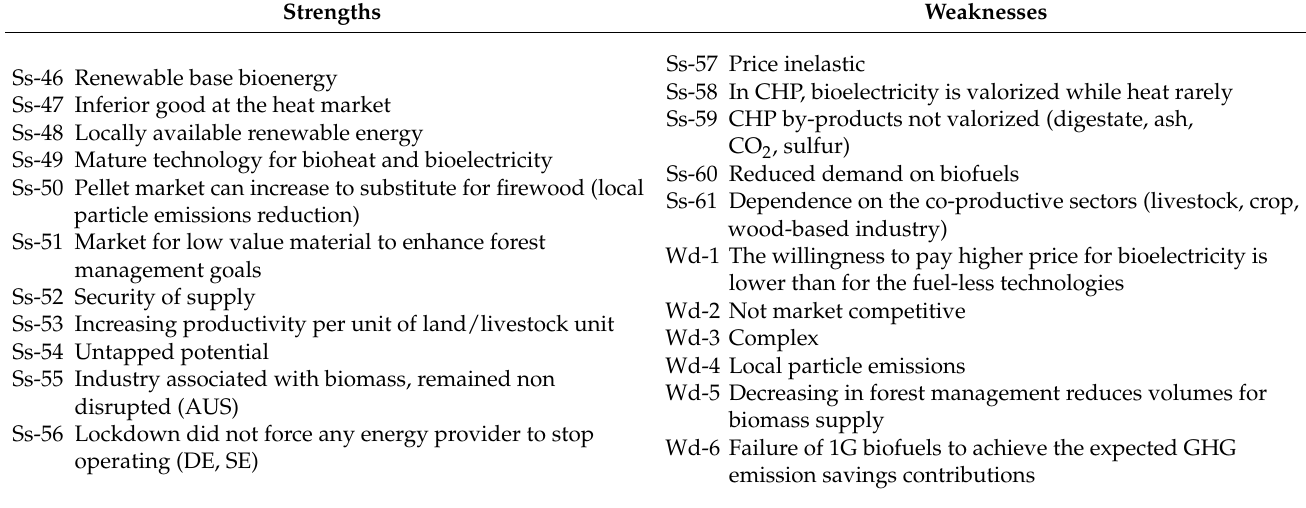
Table A3. Strengths and Weaknesses (SWOT) of biomass supply chains with respect to market demand for biomass.